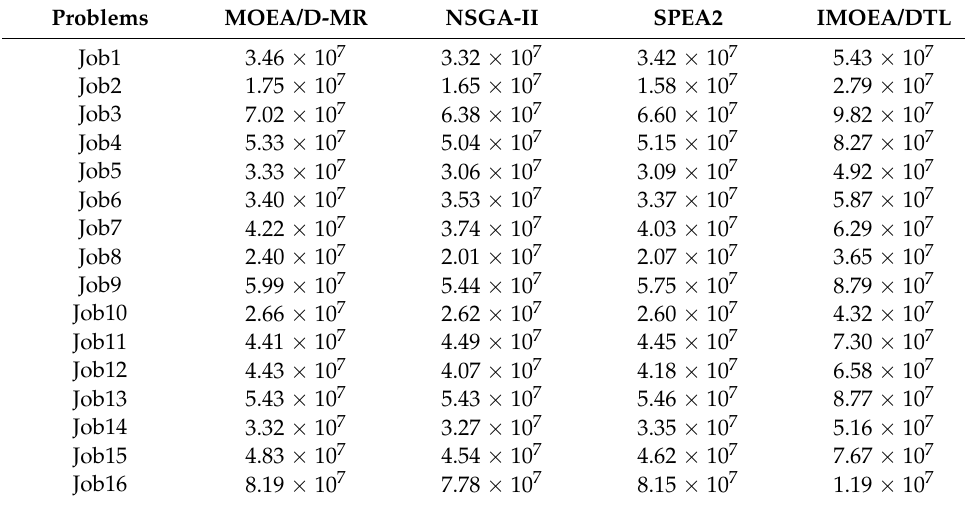
IMOEA/DTL are best in all solutions. As shown in Table 10, the solutions obtained by MOEA/D-MR, NSGA-II, and SPEA2 are inferior to that obtained by IMOEA/DTL in terms of HV -metric. The p -value of the Wilcoxon signed-rank test of the HV -metric between two algorithms is shown in Table 11. P1 represents the p -value of the Wilcoxon signed-rank test of the HV -metric between IMOEA/DTL and MOEA/D-MR, P2 represents the p -value of the Wilcoxon signed-rank test of the HV -metric between IMOEA/DTL and NSGA-II, and P3 represents the p -value of the Wilcoxon signed-rank test of the HV -metric between IMOEA/DTL and SPEA2. P1, P2, and P3 are less than 0.05, demonstrating the significant differences between IMOEA/DTL and MOEA/D-MR, IMOEA/DTL and NSGA-II, and IMOEA/DTL and SPEA2. Tables 10 and 11 indicate that IMOEA/DTL is superior to MOEA/D-MR, NSGA-II, and SPEA2 in terms of HV -metric. Table 10. Average values of hypervolume indicator ( HV -metric) of the solutions obtained by MOEA/D-MR, NSGA-II, SPEA2, and IMOEA/DTL.